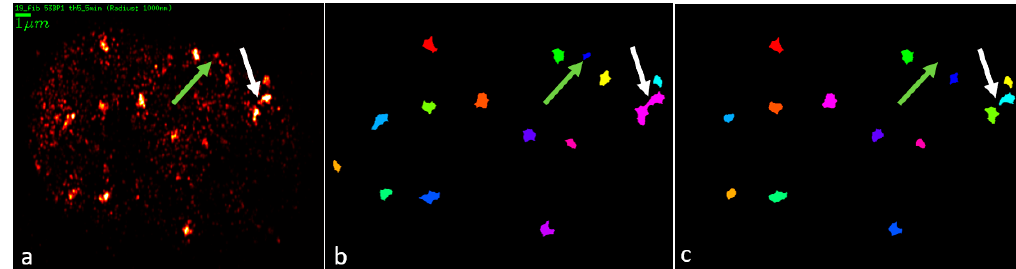
Figure 5. Exemplary images for a NHDF cell (90° irradiation) for cluster parameter comparison: ( a ) density-weighted image produced; ( b ) cluster image with minimum N = 63 neighbors; and ( c ) cluster image with minimum N = 84 neighbors. The white arrows show a separated cluster group in ( c ) and the green arrow a background signal wrongly counted as a cluster in ( b ). The different colors of the clusters are randomly chosen for better separation.